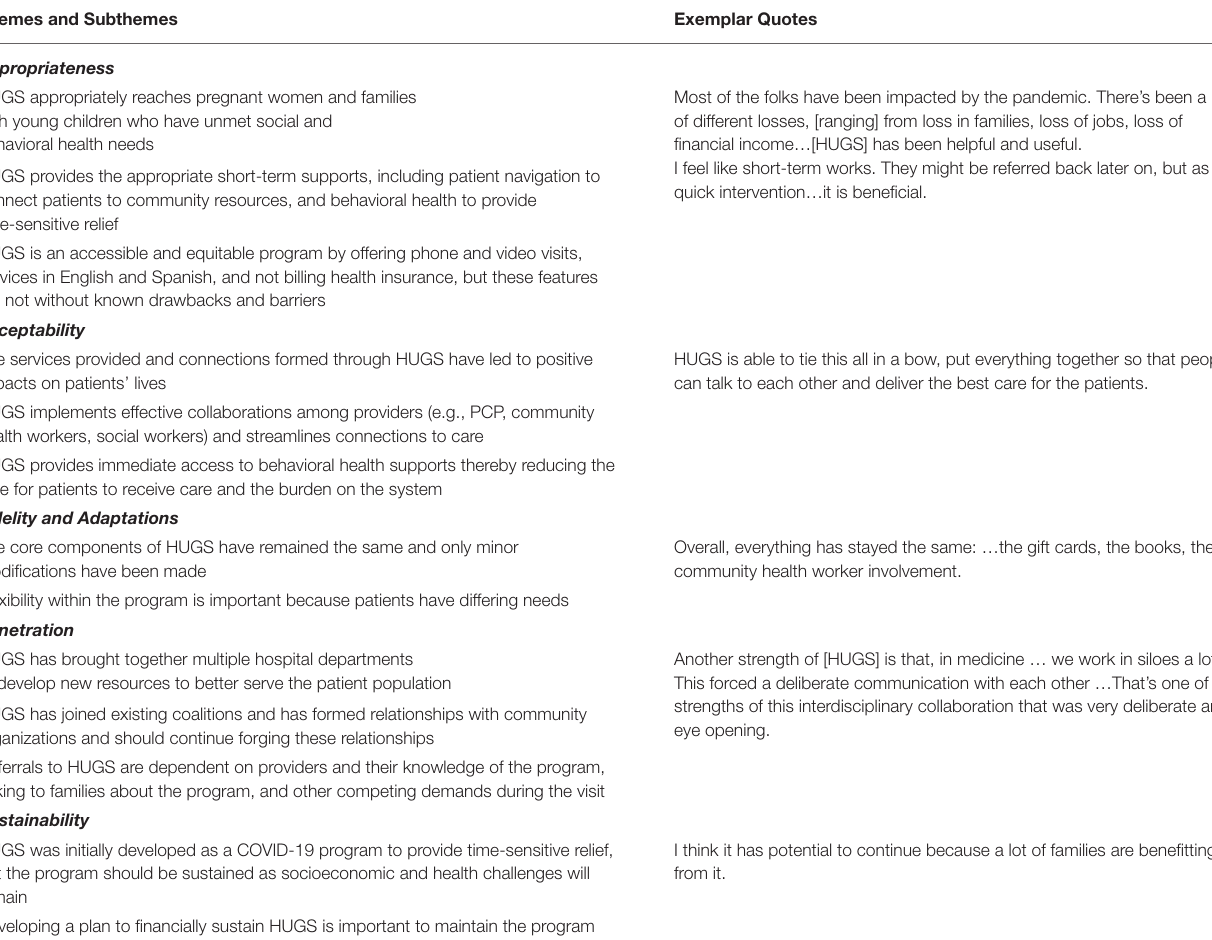
TABLE 3 | Emergent themes and exemplar quotes of the implementation of HUGS. Themes and